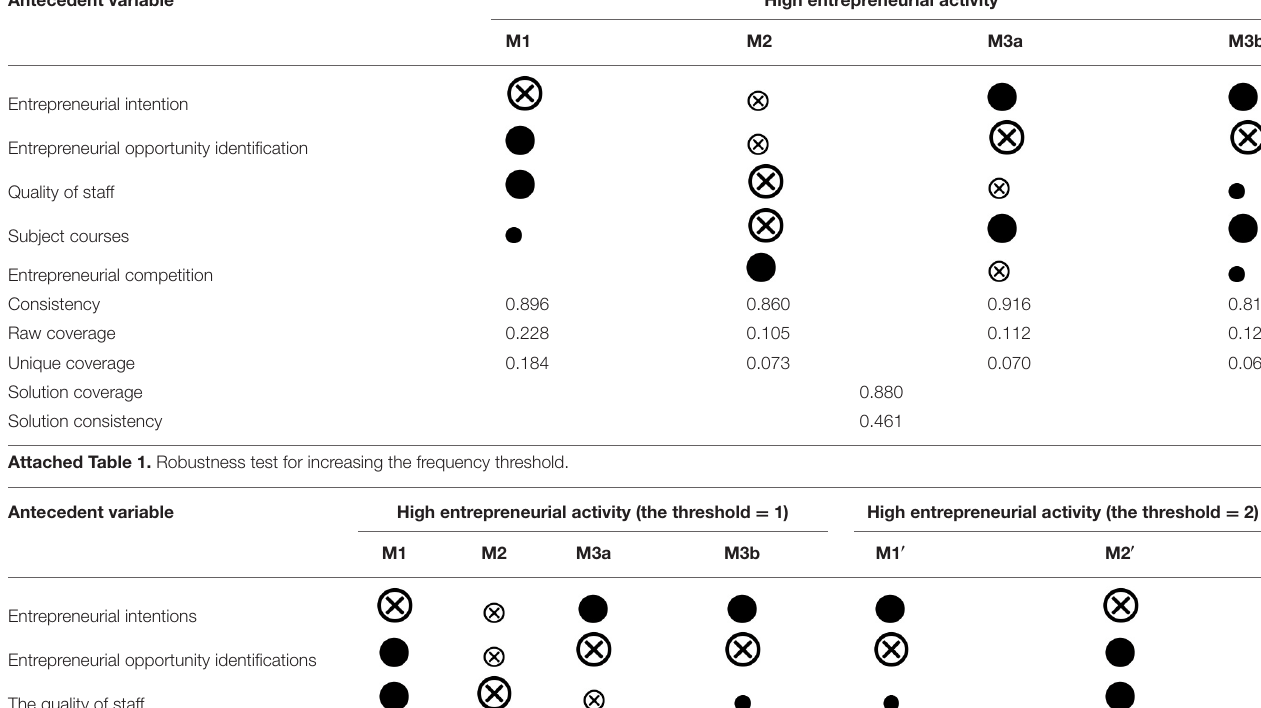
TABLE 5 | Configurations that produce high entrepreneurial activity. Antecedent variable